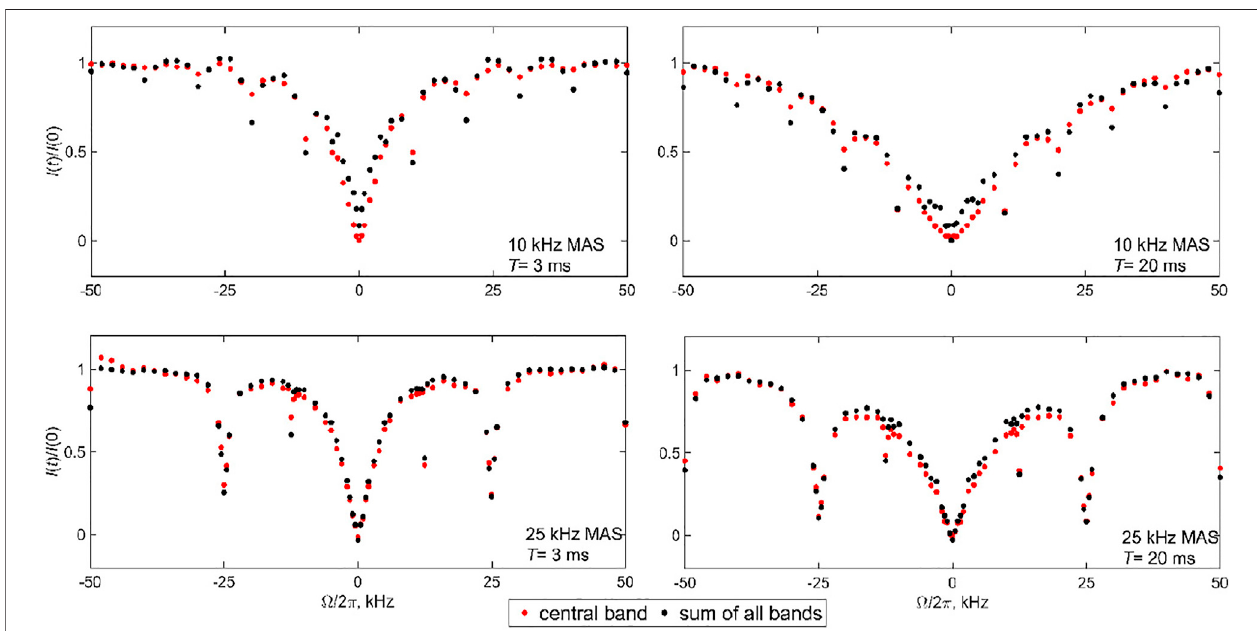
FIGURE 11 | Experimental 2 H CEST pro fi les of the A β 1-40 fi brils labeled at the A2-CD 3 side chain. The normalized integrated intensities I ( t )/ I (0) of the central band (redcircles)arecomparedwiththeintensitiesofallthespectrabandsshowninthespectraof Figure2 (blackcircles)andareplottedasafunctionoftheoffsets Ω / 2 π .The saturation times and MAS rates are shown directly on the panels. The intensities I ( t )/ I (0) are plotted as a function of the offsets Ω / 2 π . Data were collected at 17.6 T and 37 ° C with ω RF / 2 π (cid:2) 1.3 kHz and an MAS rate of either 10 or 25 kHz.